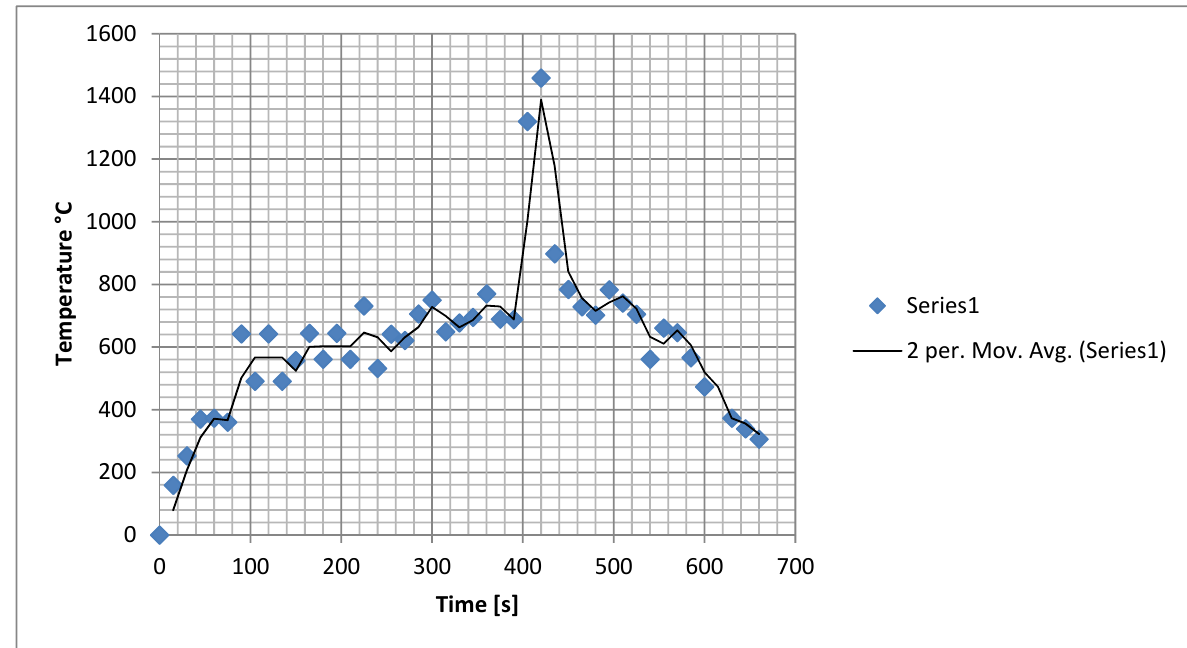
Fig.11 temperature profile for 5 tested